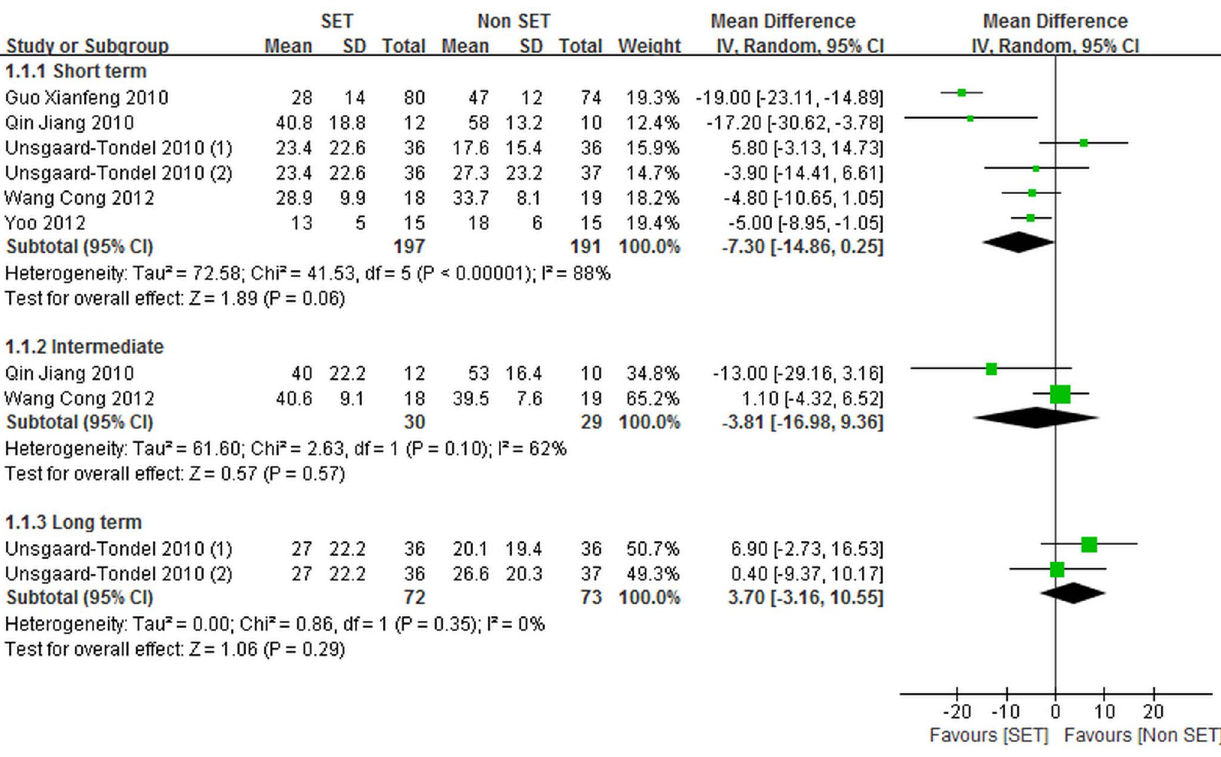
Figure 2. Self-reported pain for sling exercise versus other forms of exercise. Unsgaard-Tondel 2010(1), sling exercise versus motor control exercise; Unsgaard-Tondel 2010(2), sling exercise versus general exercise.